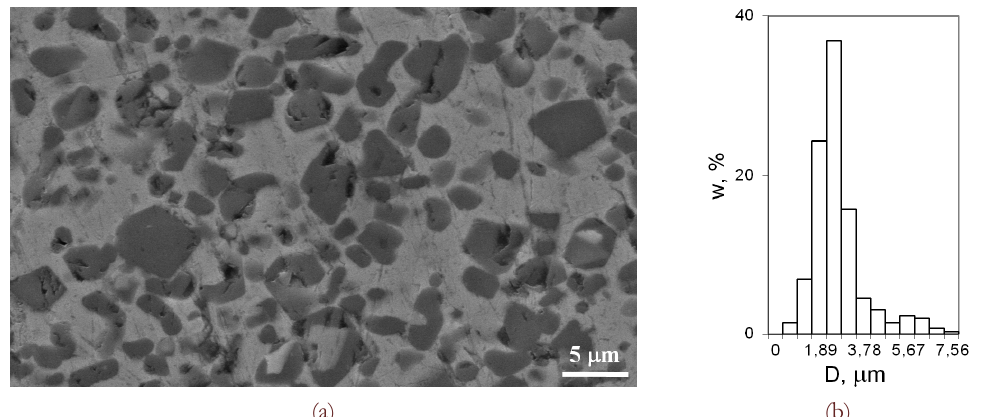
Figure 8: (a) Typical microstructure of TiC-particle-reinforced Ni-Cr matrix composite (50 vol.% TiC); (b) size distribution of carbide particles ( D = 2.7  1.2  mean